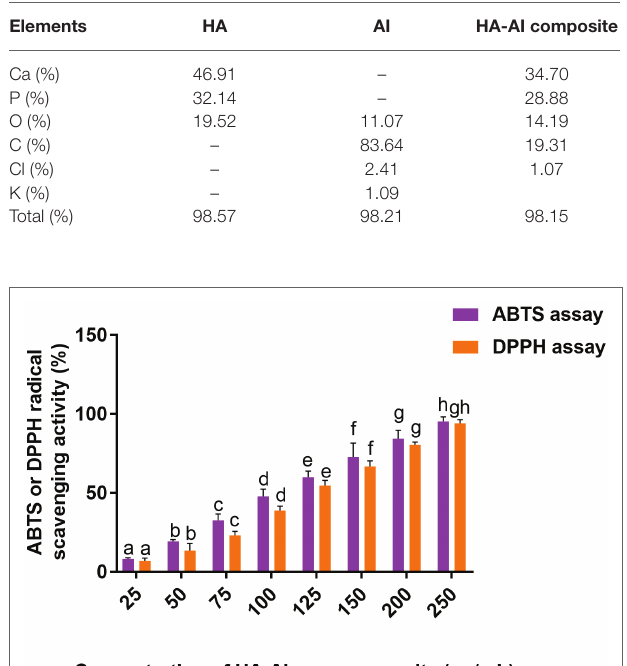
FIGURE 5 | ABTS and DPPH radical scavenging potentials of hydroxyapatite– A. indica (HA-AI) composite. The experiments were performed individually in six replicates and achieved results were stated as mean ± standard deviation. The data were statistically evaluated by one-way ANOVA following Tukey’s post hoc multiple comparison test. The statistical variance among the experimental groups was measured as significant at p < 0.05. The columns with different alphabets were significant within the respective study.